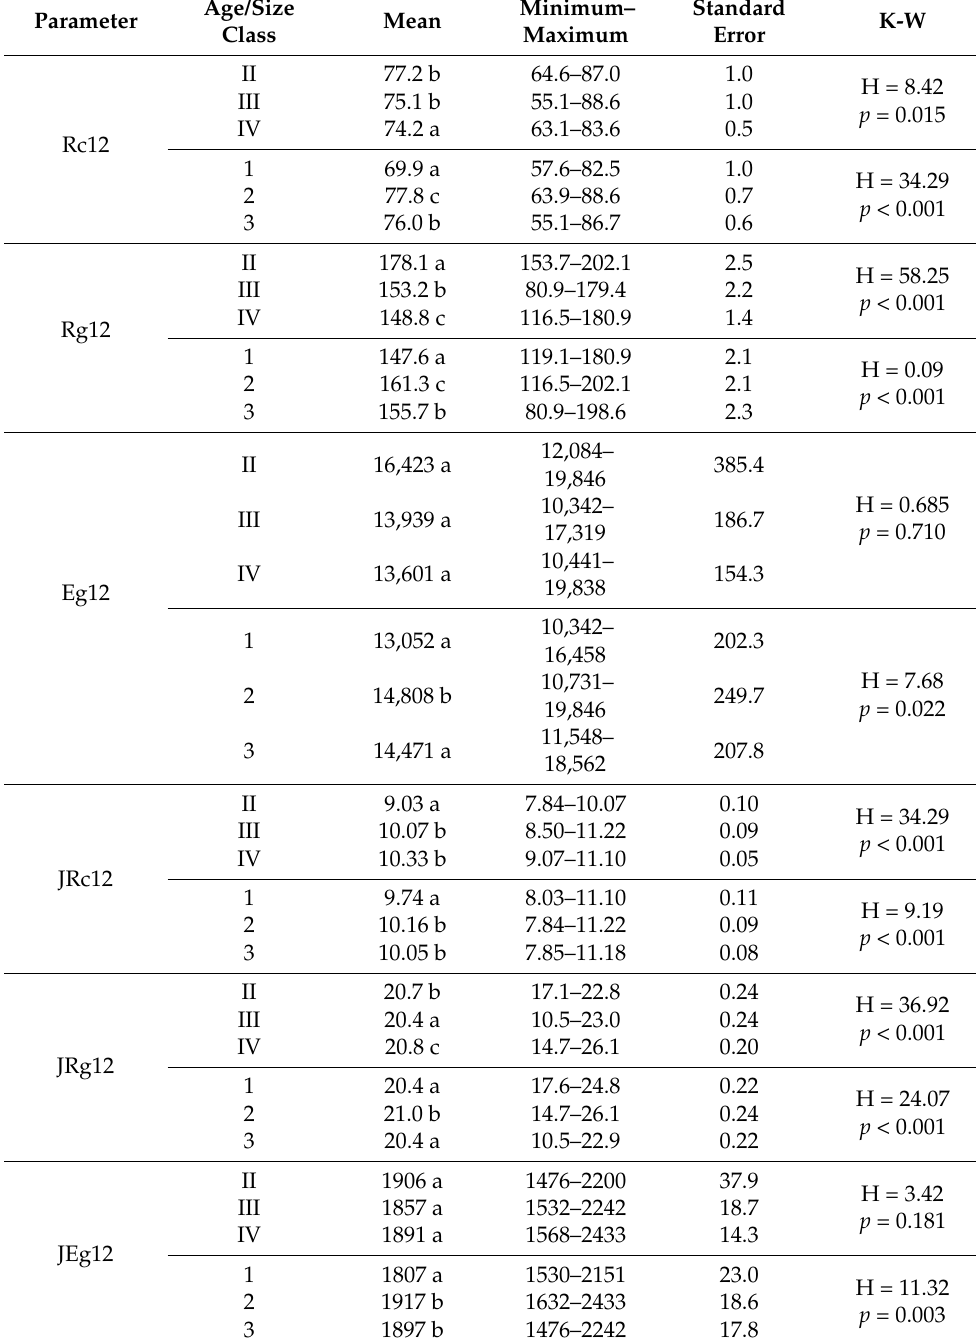
Table 4. Basic characteristics of compression strength parallel to the grain (Rc12, MPa), static bending (Rg12, MPa), modulus of elasticity in static bending (Eg12, MPa) and their coefficients (JRc, JRg, JEg, respectively, km) of black locust wood in relation to tree’s age class (II–IV) and size class (1–3) as well as parameters of Kruskal–Wallis comparison